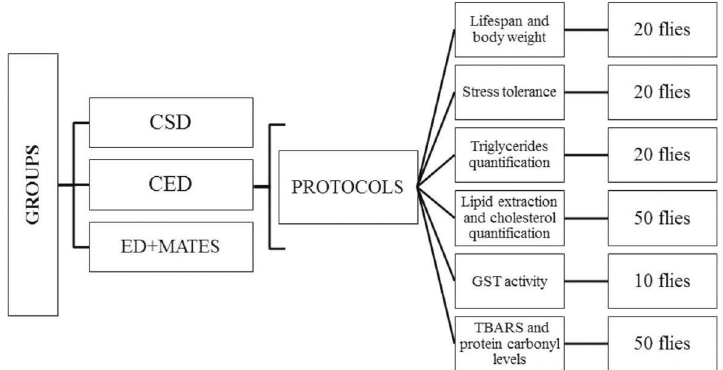
Figure 1. Flow diagram of the trial design. All experiments were performed in triplicate. CSD: control standard diet; CED: control experimental diet; ED + mates: experimental diet with yerba mates extracts; GST: glutathione S-transferases; TABRS: thiobarbituric acid reactive